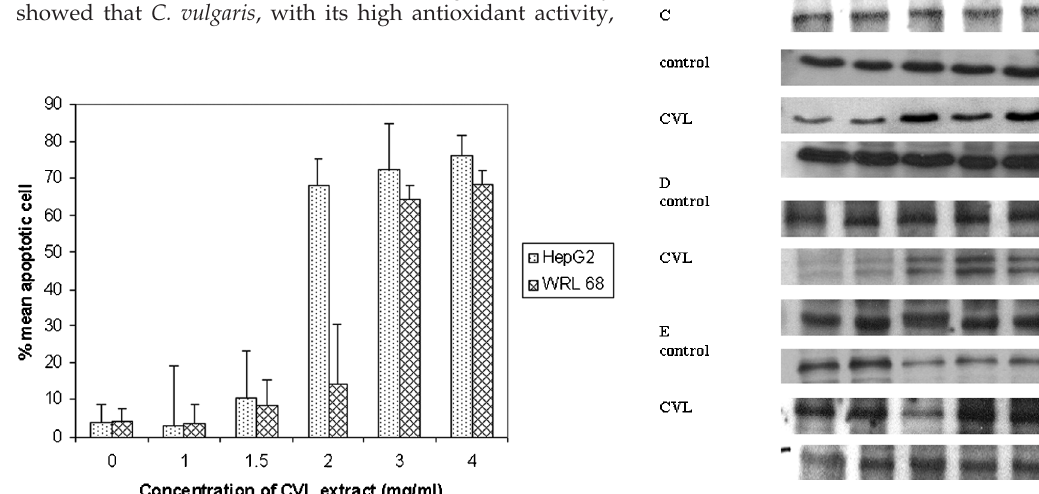
Figure 3 - The effect of Chlorella vulgaris extract on apoptosis of HepG2 and WRL68 cell lines. Data are represented as mean ¡ SD. * showed significant changes (p , 0.05) for n=3 triplicate after 24 hours of treatment with different concentrations of C. vulgaris extract using TUNEL assay. Per cent apoptotic cells are scored by taking an average of 1000 cells in 10 random fields. Apoptotic cells are almost absent in untreated and at 1 mg/ml of C. vulgaris but present quantitatively in HepG2 cells at higher concentrations of C. vulgaris .